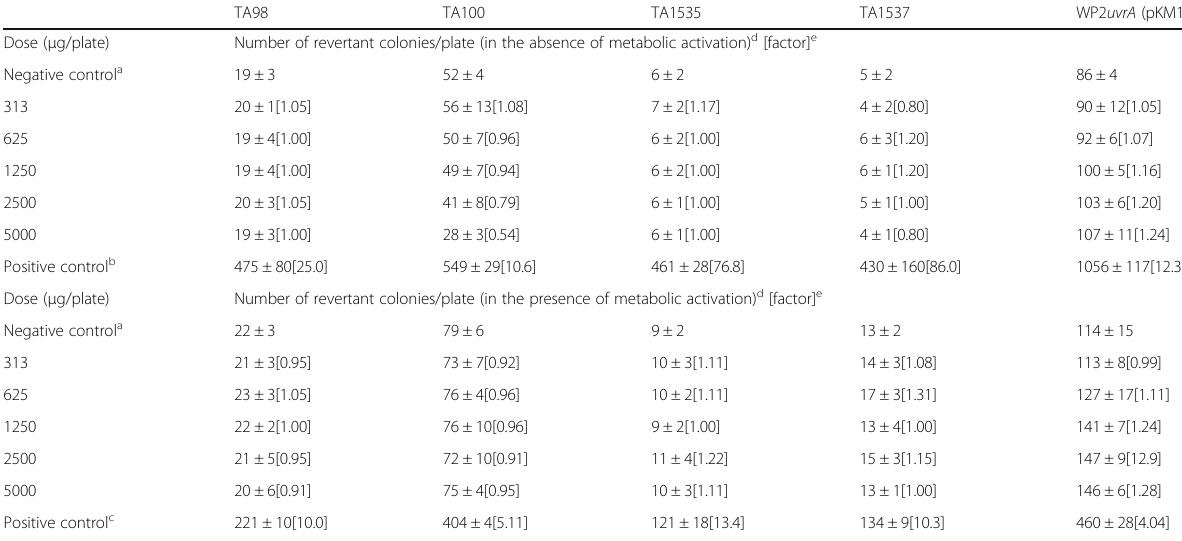
Table 1 Results of the bacterial reverse mutation test for SOCG